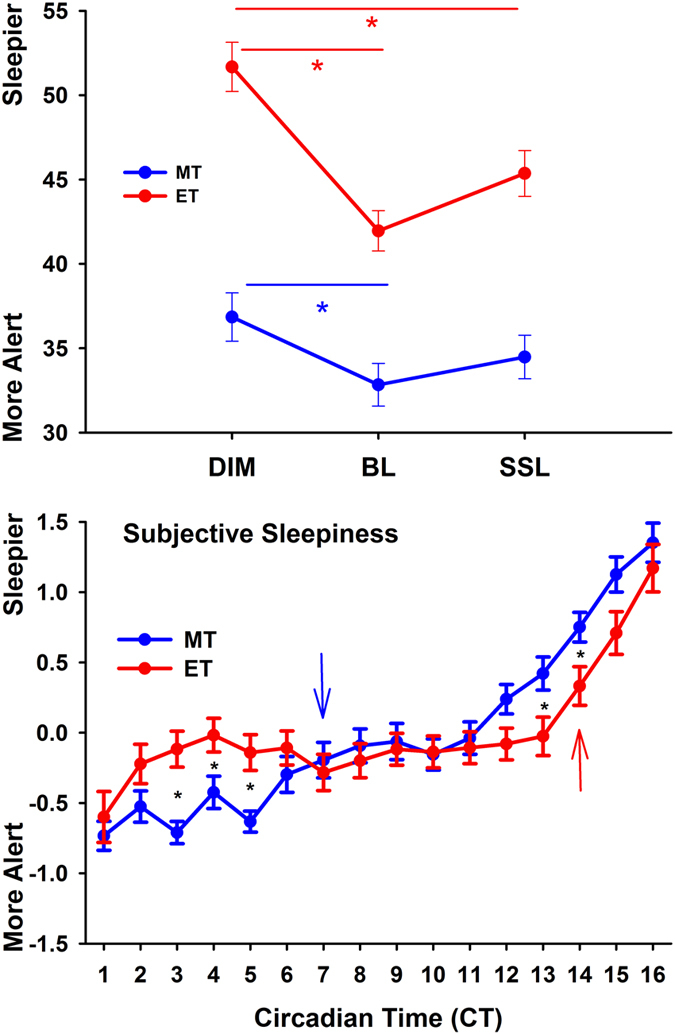
Subjective sleepiness per condition and chronotype (upper graph; blue symbols = MT; red symbols = ET); *significant differences within each chronotype and condition (N = 32; means ± SEM; ‘chronotype’ × ‘condition’; p < 0.05).The lower graphs shows the time course of subjective sleepiness (standardized data) for MT (blue symbols) and ET (red symbols). The blue and red arrow show the increase in sleepiness since CT 1 (=one hour after habitual wake time) for the respective chronotypes.